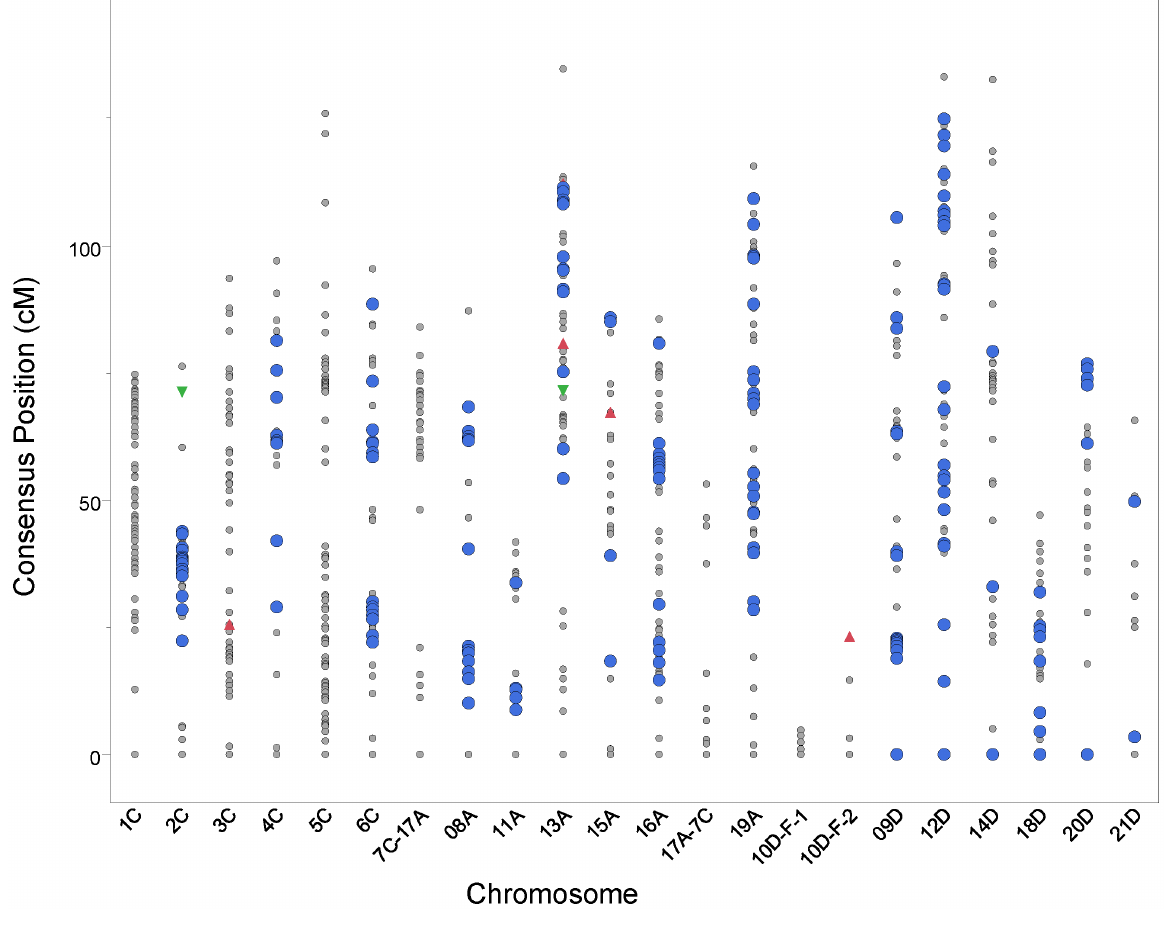
Figure 3. Chromosome anchoring of consensus linkage map. Grey dots indicate positions of non-anchored markers on each linkage group, while colored dots indicate positions of physically anchored SNPs (blue dots), DArTs (red up arrows), and RFLPs (green down arrows).